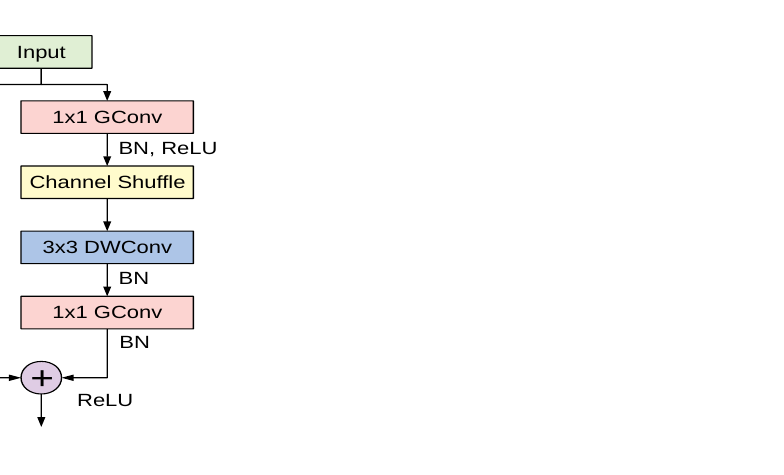
Figure 5. The building unit of the ShuffleNet